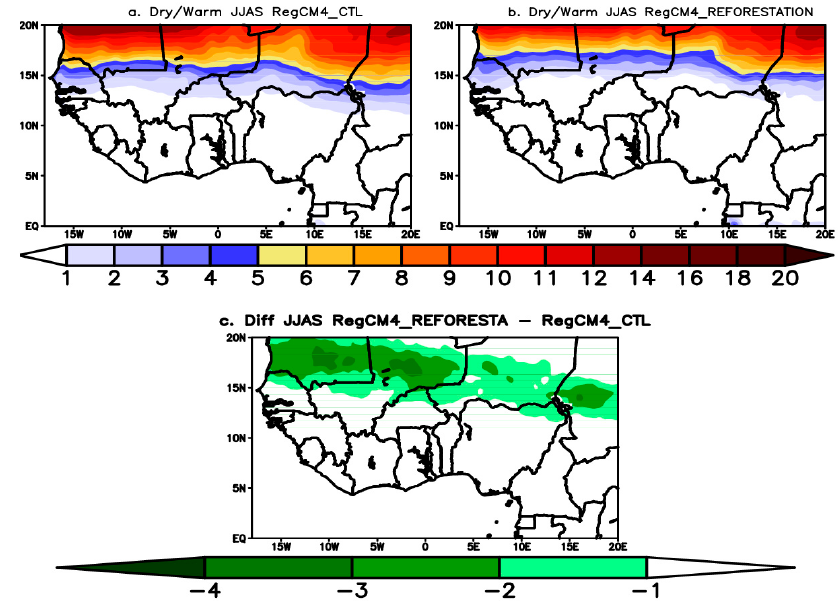
Figure 7. Number (expressed in days) of compound dry/warm during the JJAS period averaged from 1990 to 2009 over West Africa for: ( a ) RegCM4_CTL; ( b ) RegCM4_REFORESTATION and ( c )